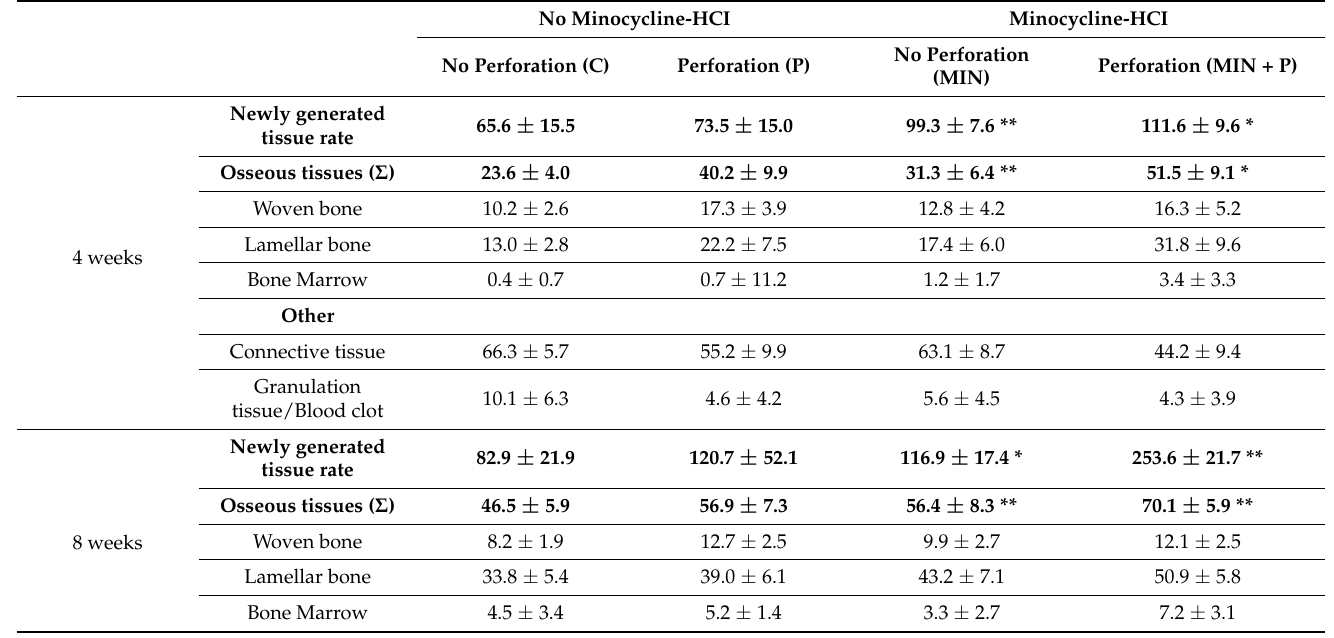
Table 2. Influence of Minocycline-HCI and of cortical perforations on de novo extra-skeletal bone